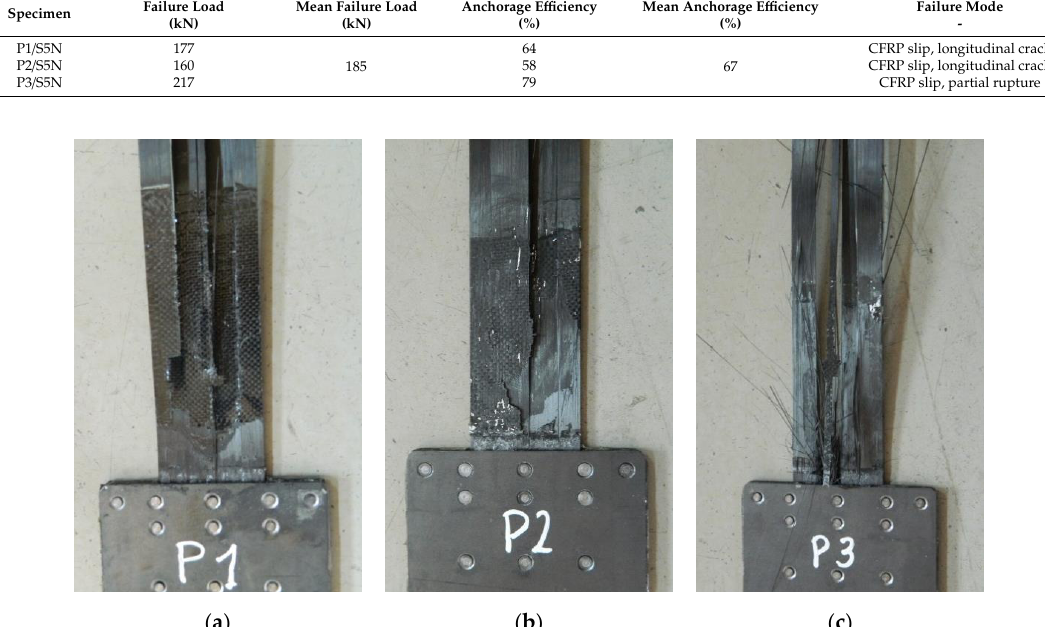
Table 9. Summary of the test results in the subsequent test series.